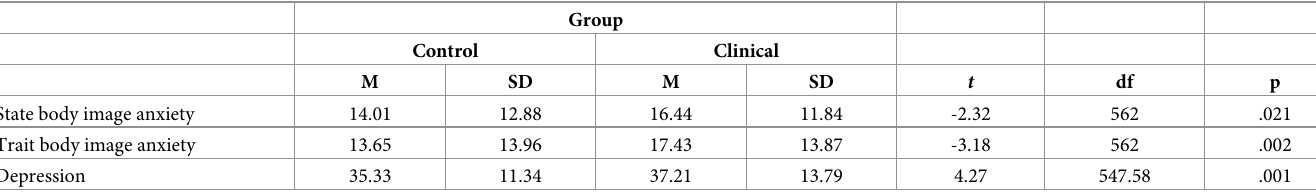
Table 3. Mean values of body image anxiety and depression for both